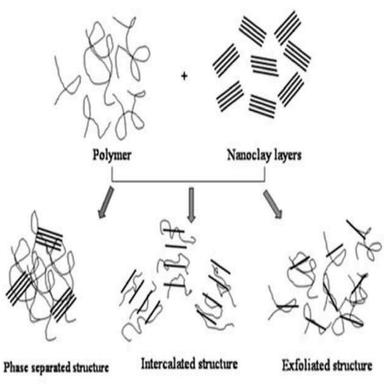
Dispersion of nano-clays in the polymer.